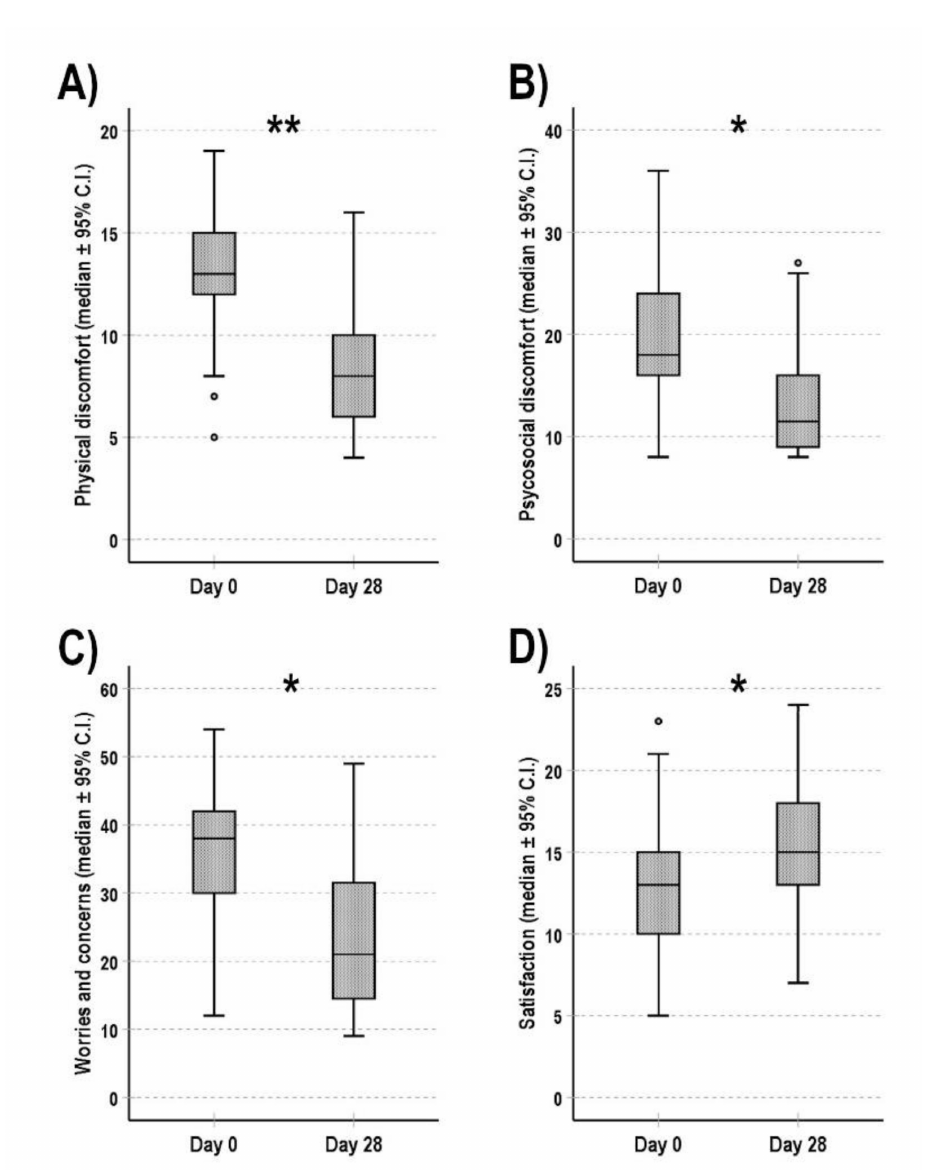
Figure 2. Constipation-related quality of life at the baseline (day 0) and after 4 weeks of follow up (day 28). The scores obtained in the four dimensions of PAC-QoL questionnaire (( A ) physical discomfort, ( B ) psychological discomfort, ( C ) worries/concerns and ( D ) satisfaction) are shown as median (95% C.I.). * p < 0.010; ** p <